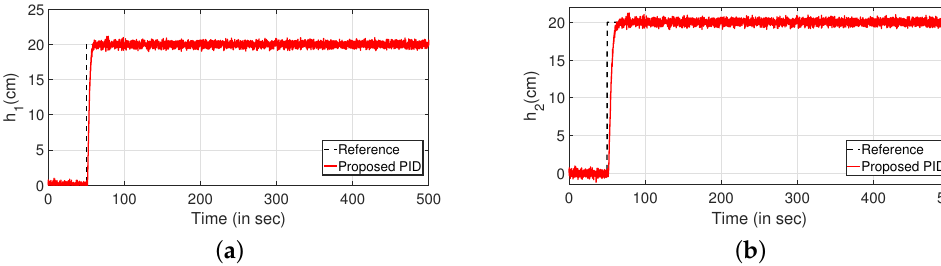
Figure 10. Reference tracking for PID controller with input uncertainties. ( a ) Level Variation in tank 1. ( b ) Level Variation in tank 2.